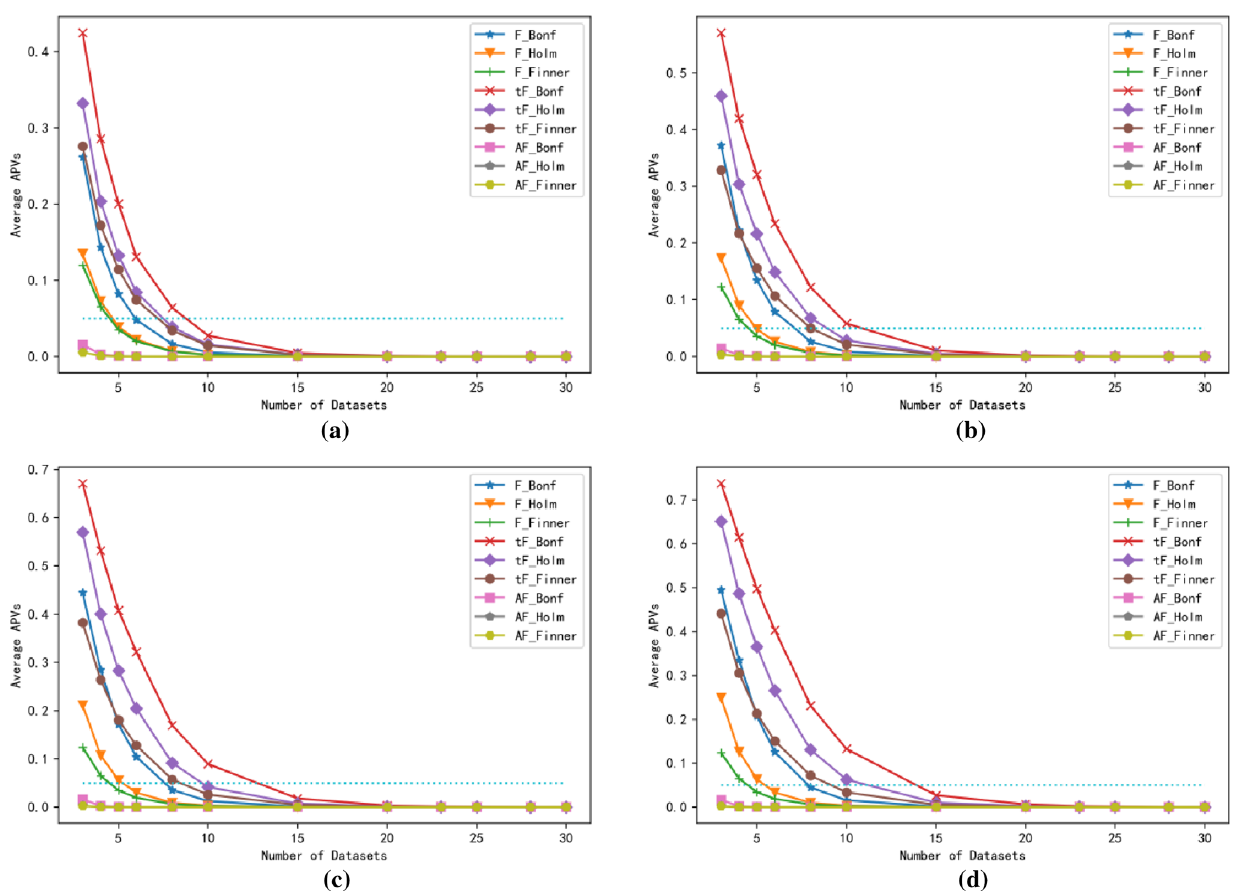
Fig. 11 Average APVs of different nonparametric statistical tests under the experiment setting vii: a the number of algorithms K = 4; b K = 6; c K = 8; d K =